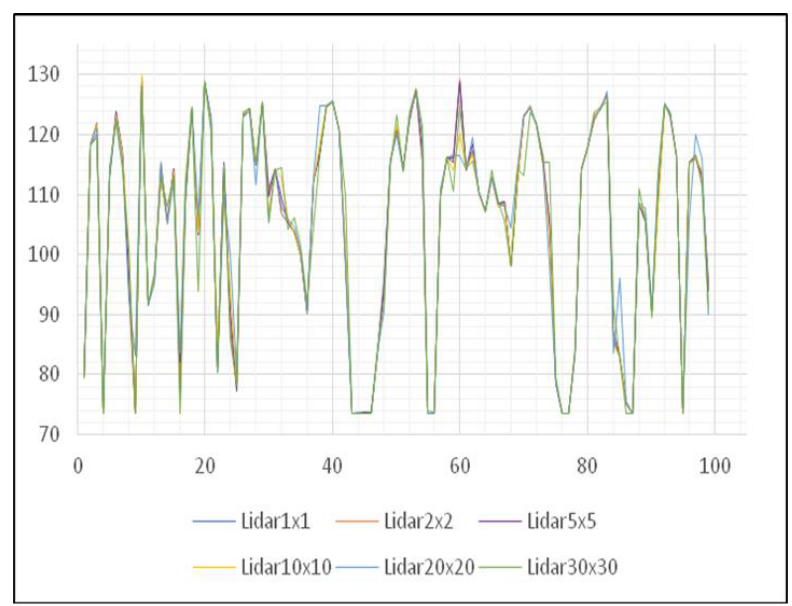
Figure 11. Movement of corrected values of height of DEM of the Center area.